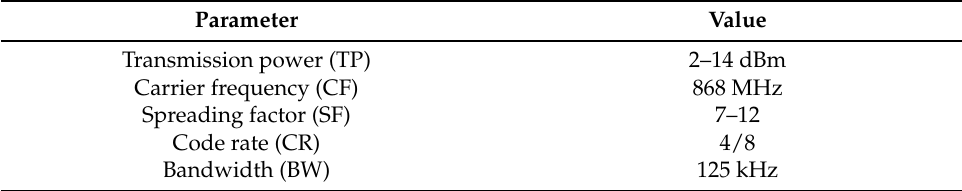
Table 2. Simulation parameters in urban